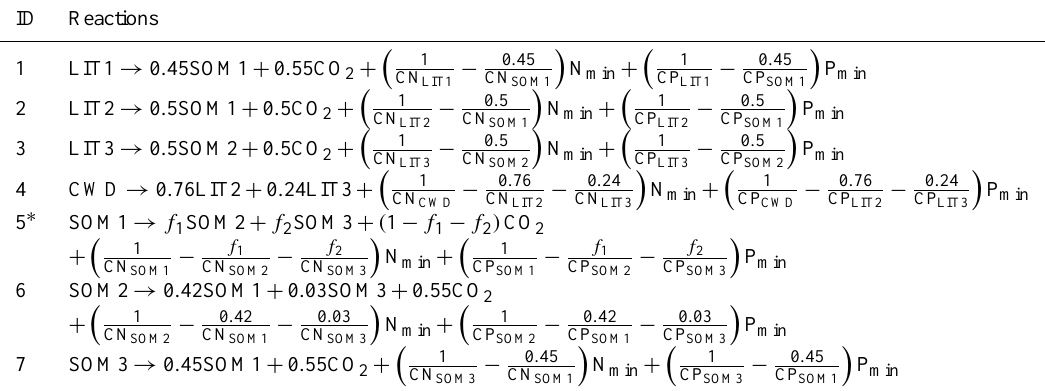
Table 1. A list of biogeochemical reactions as represented in the CENTURY-like organic matter decomposition model (Appendix A). The decomposition is calculated as in Parton et al. (1988). Here we use CN to represent carbon to nitrogen ratio, and CP to represent carbon to phosphorus ratio. The subscript “min” designates mineral pool for a nutrient, such as nitrogen (N) and phosphorus (P). ID